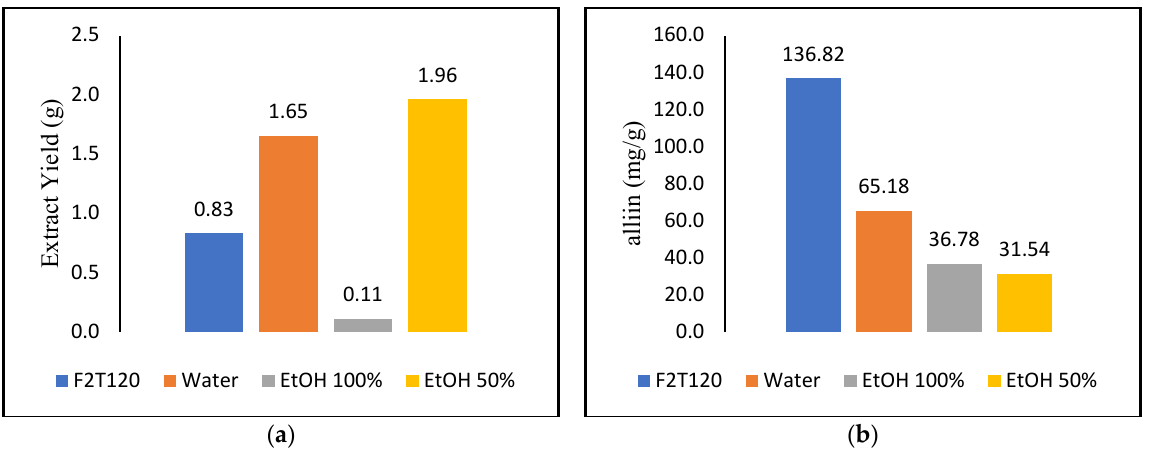
Figure 5. Comparison of ( a ) extraction yield and ( b ) alliin ( b ) between the optimum parameters of SWE and Soxhlet extraction.